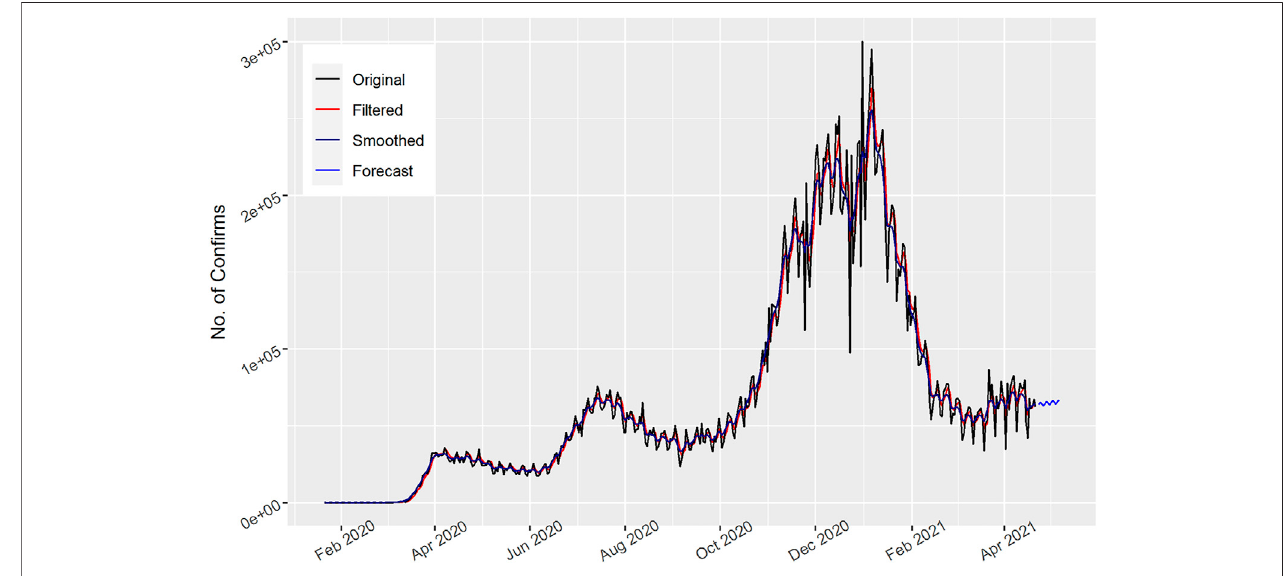
FIGURE 1 | Number of daily Con fi rmed cases in the United States.